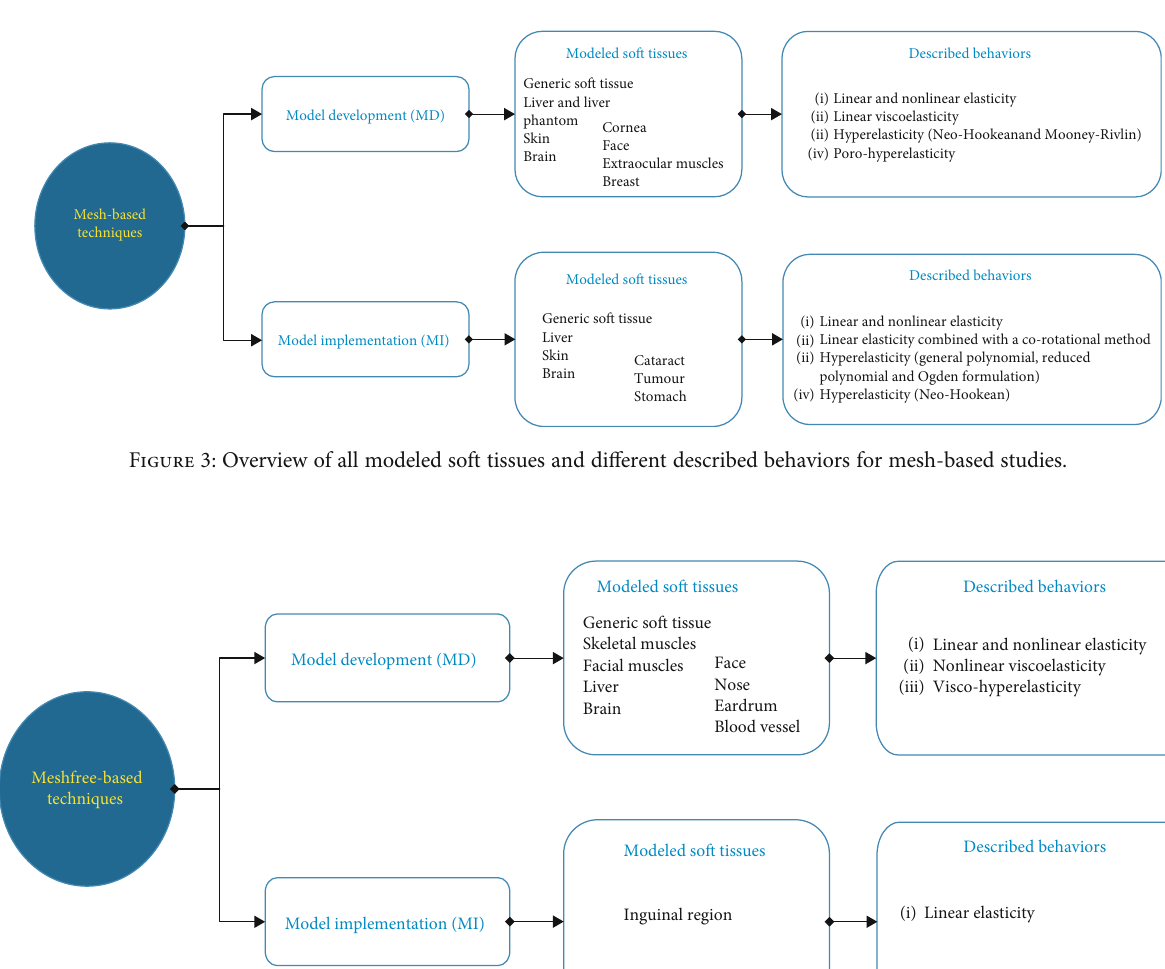
Mesh-based techniques